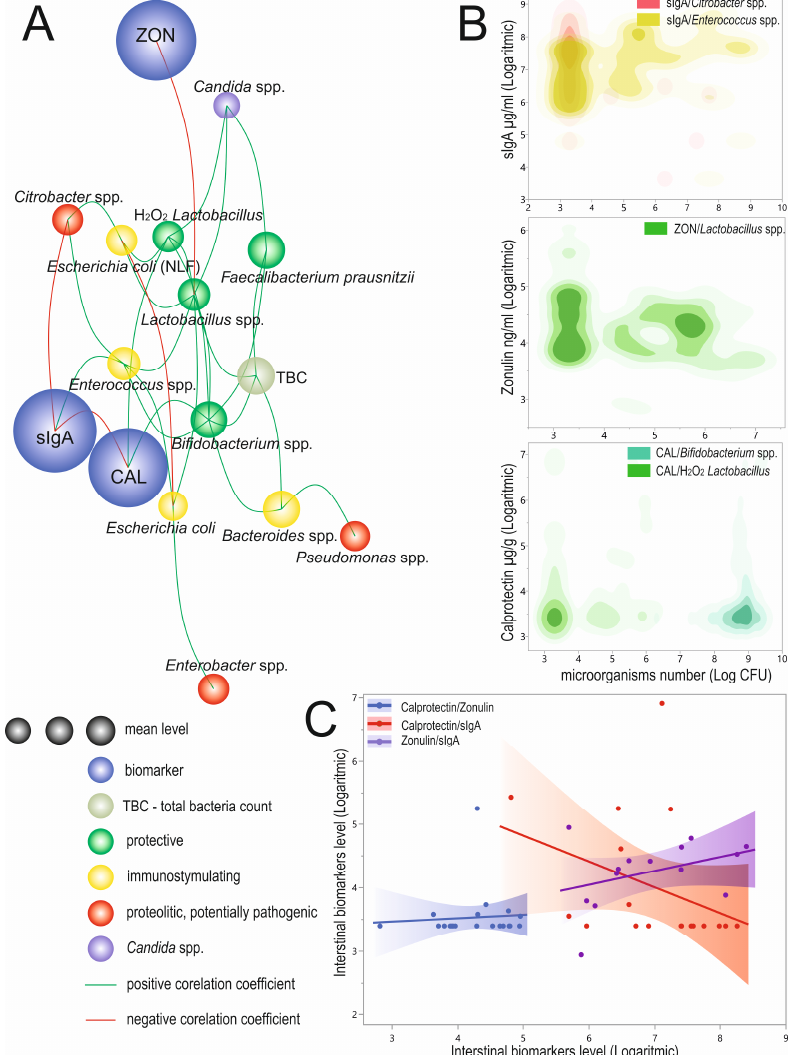
Figure 6. Linkage distances between analyzed biomarkers and analyzed microorganisms. The length of each line represents the strength of the correlation coefficient ( A ). In the case of the circle diameter of microorganisms, the circle size represents the mean level. The biomarker circle size was not scaled. Significant correlations of analyzed biomarkers and microorganism species ( B ) and correlation between logarithmic transformed biomarker levels ( C ). CAL—calprotectin; sIgA—secretory immunoglobulin A; ZON—zonulin; TBC—total bacteria count; NLF—non-lactose fermenting; Log CFU—logarithmic transformed colony-forming units.